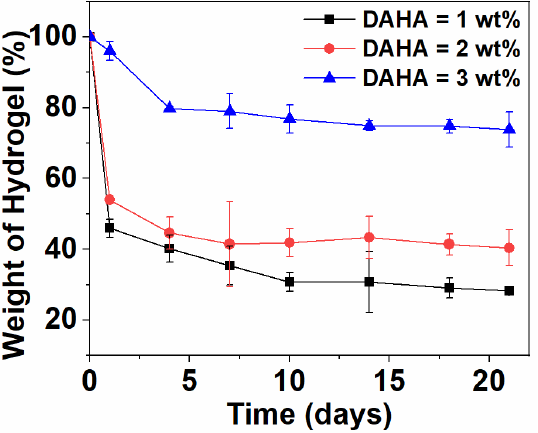
Figure 8. In vitro degradation of DACS hydrogels with different concentrations of DAHA (1.0–3.0 wt%).